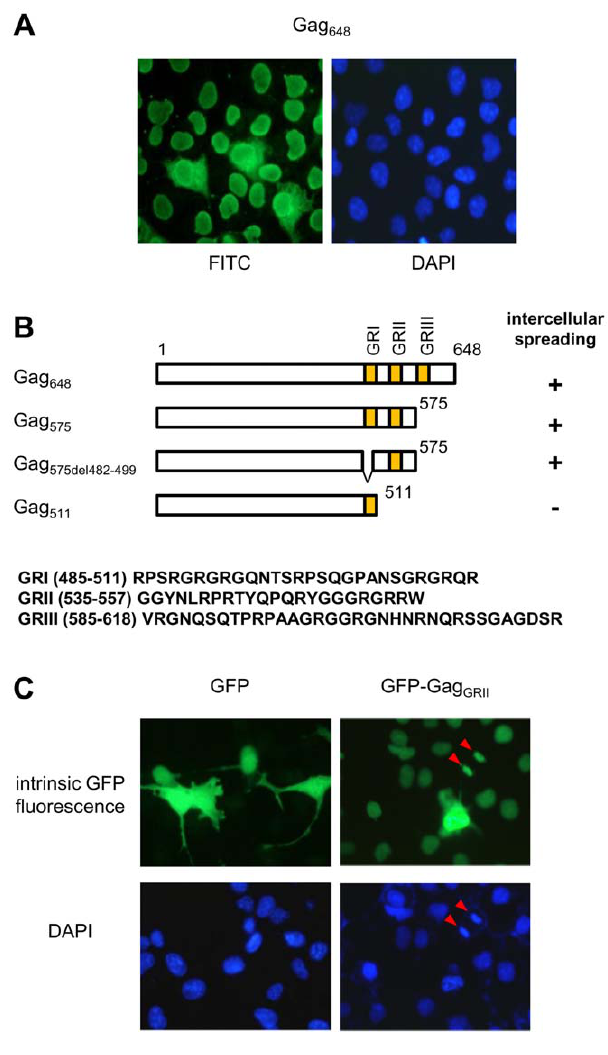
Figure 1. Intercellular spreading of full-length and C-terminal deletion mutant PFV Gag proteins. A . Distribution of full-length Gag (Gag 648 ) in cells was analyzed by indirect immunofluorescence. Forty-eight hours after transfection, cells were fixed with methanol, labeled with anti-Gag antibodies followed by fluorescein-isothiocyanate coupled secondary antibodies and visualized on a fluorescence microscope. Nuclei were stained with DAPI. Original magnification 6 40. B . The intercellular trafficking of full-length and C-terminal deletion mutant Gag proteins was followed as in A. In the illustration, numbers mark the first and last amino acids which are preserved after deletion. The glycin/arginine-(GR)-rich boxes are indicated by shaded regions and their location and amino acids composition are represent- ed below according to [31]. The plus sign corresponds to 100% of positive cells, whereas the minus sign indicates that only transfected cells are positive. C . Following methanol fixation, cells expressing GFP or GFP-Gag GRII were examined for intrinsic fluorescence. Nuclei are stained with DAPI. Original magnification 6 40. Red arrows indicate a cell undergoing